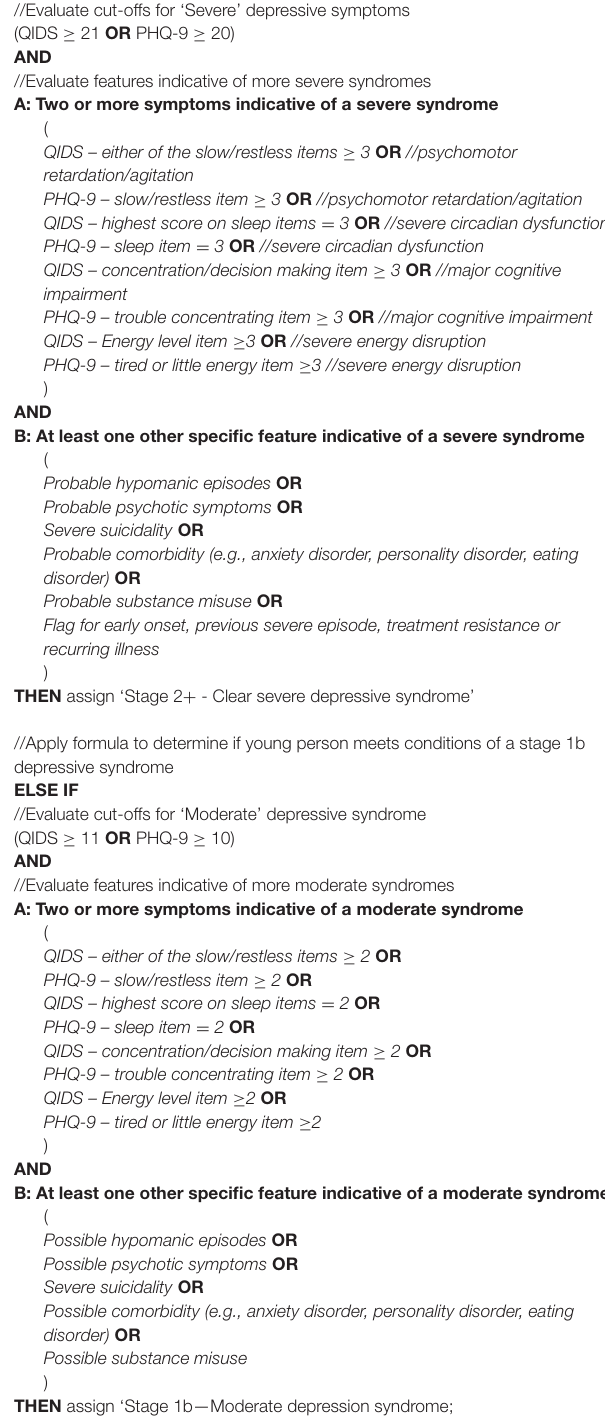
depressive syndrome